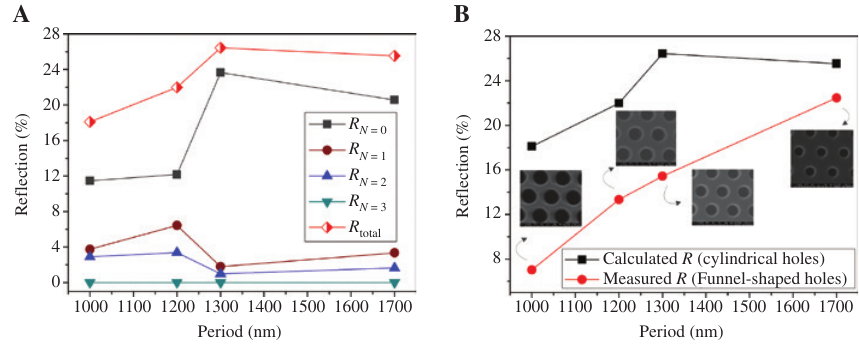
Figure 2: Calculated and measured reflection properties of photon-trapping holes. (A) RCWA calculated reflection diffraction efficiency ( R ) at different diffraction orders ( N ) and total reflection ( R ) versus period (in the N total x direction) for cylindrical hole array in hexagonal lattice with a diameter of 700 nm on Si substrate. (B) RCWA calculated reflection of cylindrical hole array and measured reflection of funnel-shaped hole array in hexagonal lattice at different periods (in the x direction) with a diameter of 700 nm. (Inset) Top views of funnel-shaped hole arrays in hexagonal lattice integrated in the photodiodes with different periods. Note that the calculation is for cylindrical holes and the measured data are for funnel-shaped